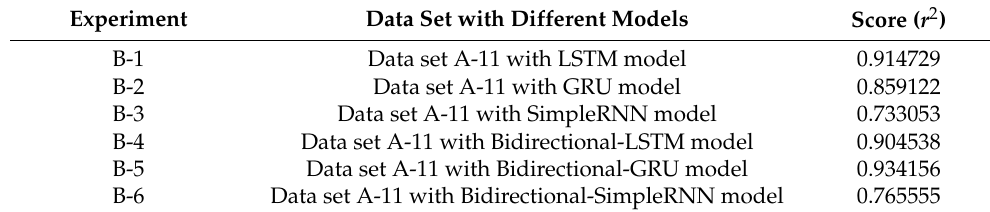
Table 6. Summary of experimental performance among different models with measurement indica- tors (Stage